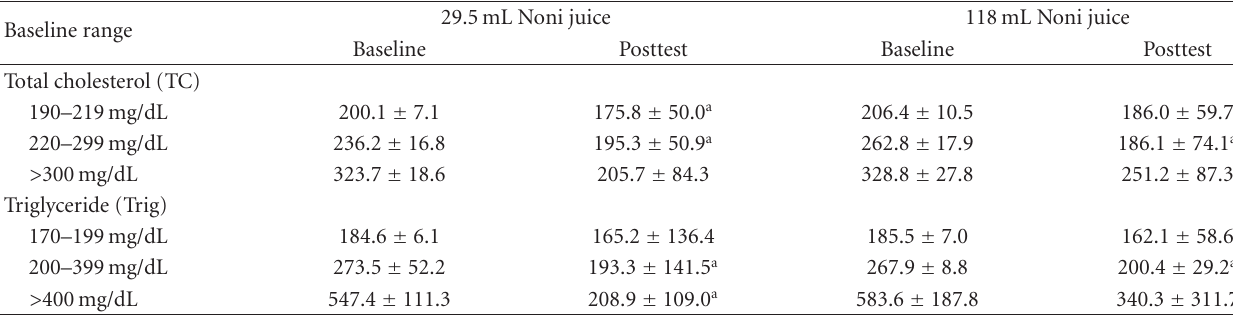
Table 3: Total cholesterol (TC) and triglyceride levels within specified baseline ranges among noni juice dose groups.